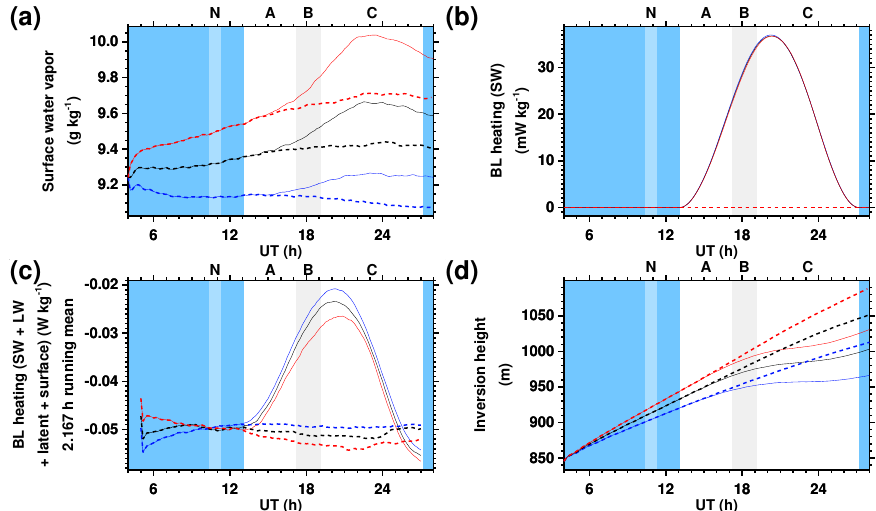
Figure 6. Wind speed and the diurnal cycle. Time series from simulations M − (blue), M 0 (black), M + (red), solid curves, and from simulations M − (blue), M 0 (black), M + (red), dashed curves. A low-pass (running mean) filter was applied where indicated to reduce dark dark dark